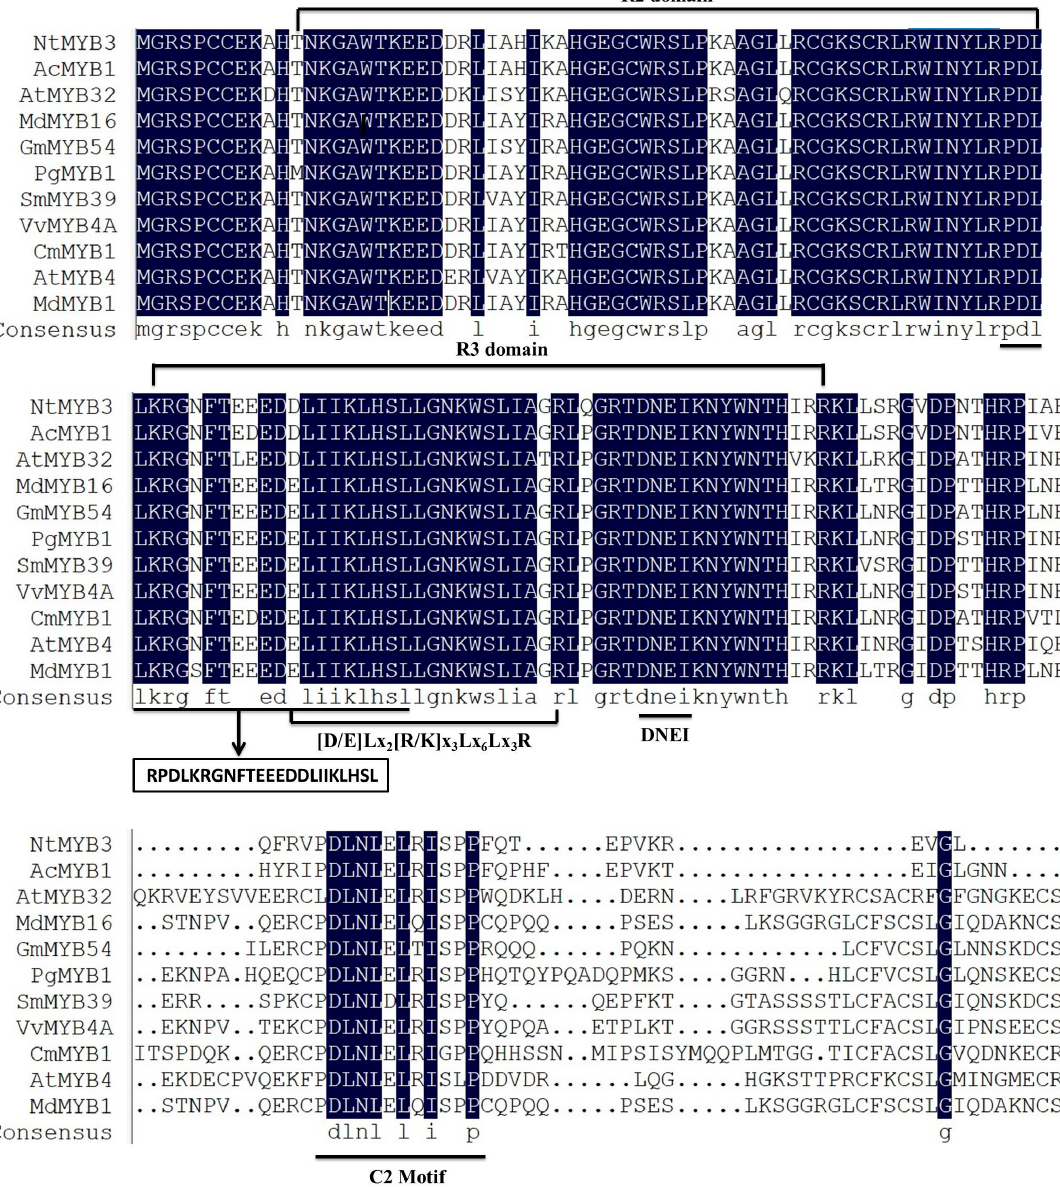
Figure 2. Multiple alignments of the protein sequences of NtMYB3 with other R2R3-MYB repressors belonging to subgroup 4. Blue shaded are indicated the 100 % homology suquences of amino acids.